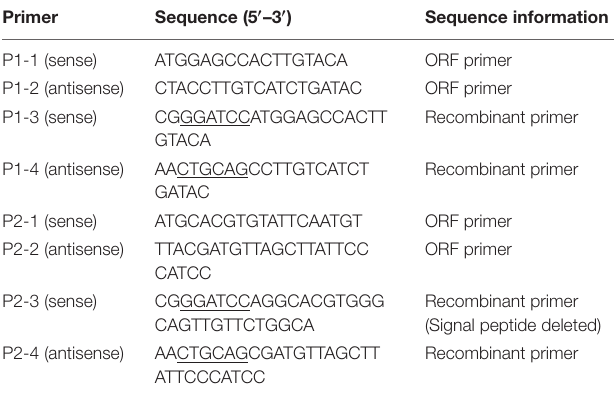
TABLE 1 | Primers used in the present